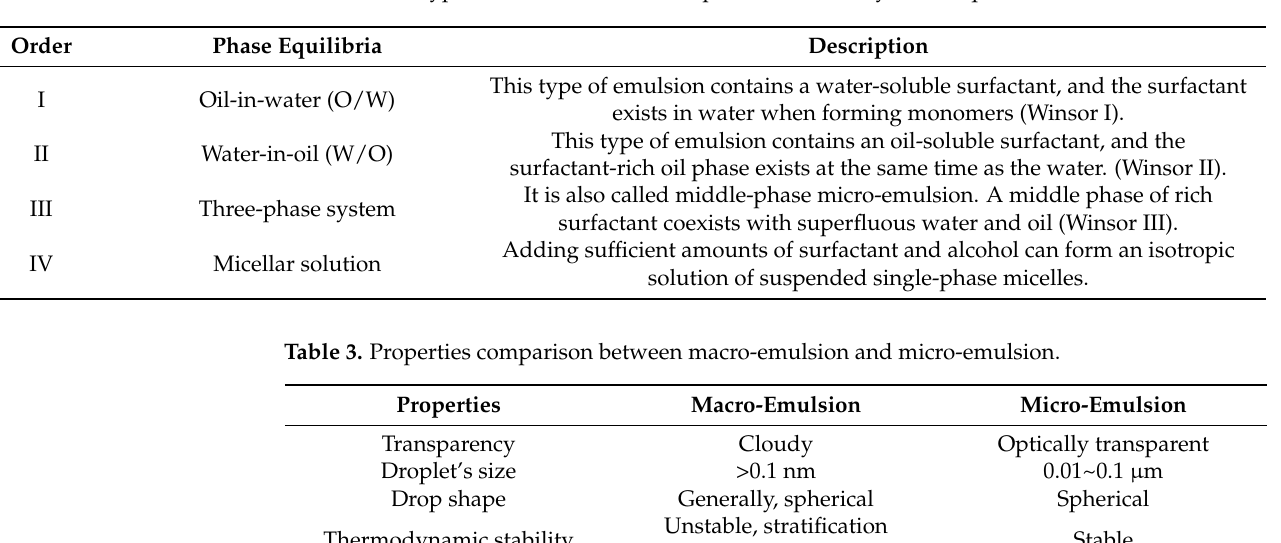
Table 2. Four types of micro-emulsions depend on thermodynamic equilibrium.